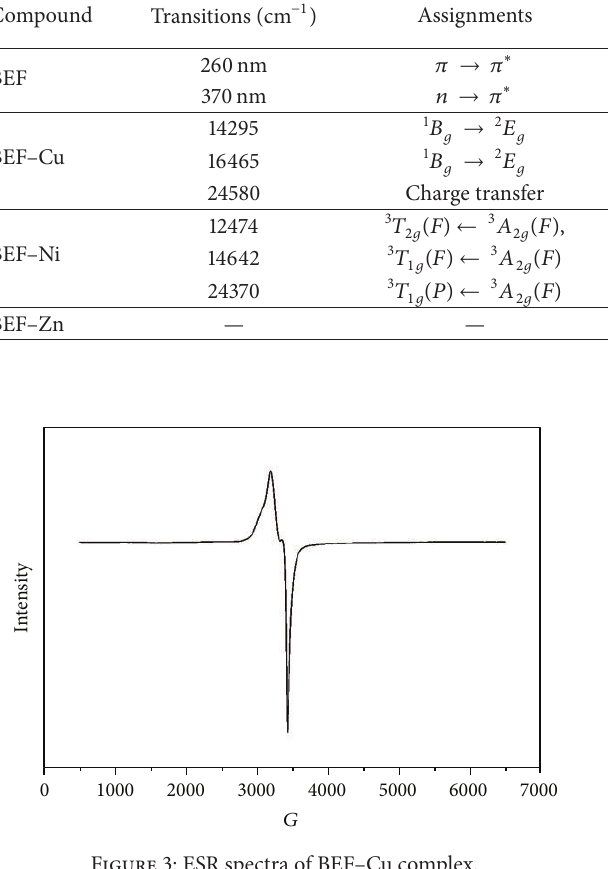
Figure 3: ESR spectra of BEF–Cu